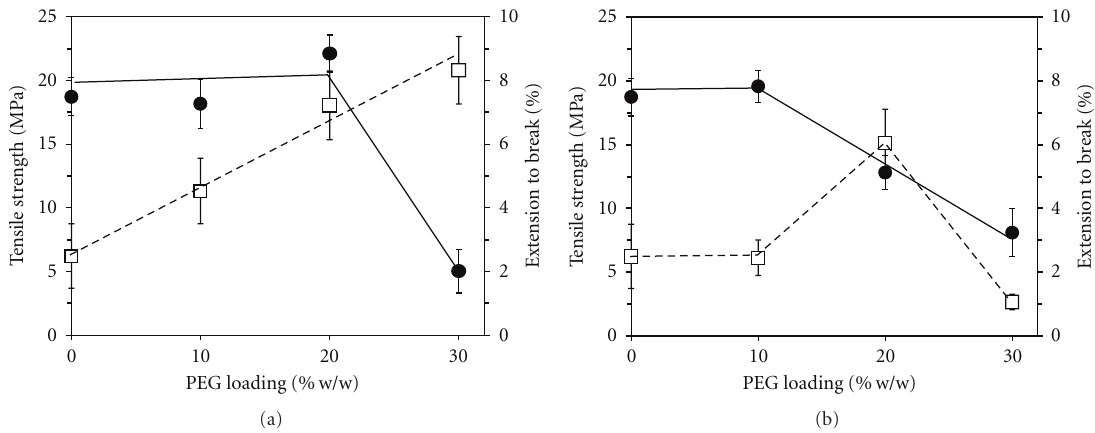
Figure 2: Change in material properties for PHB/PEG composite films with variations in PEG loading (% w/w), (a) PEG106 and (b) PEG2000; ( • ) tensile strength (MPa) and ( (cid:2) ) extension to break (%).